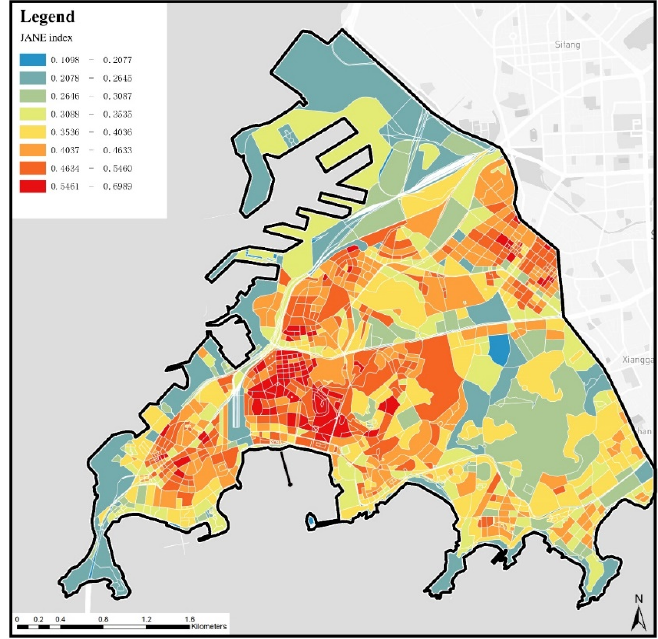
Figure 9. JANE Index of urban vitality.